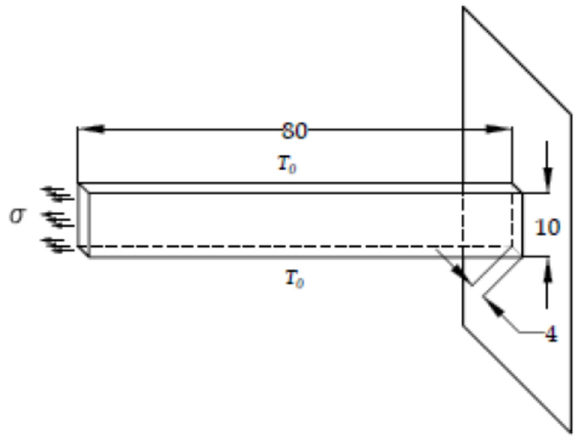
Figure 20. Geometry and boundary conditions.